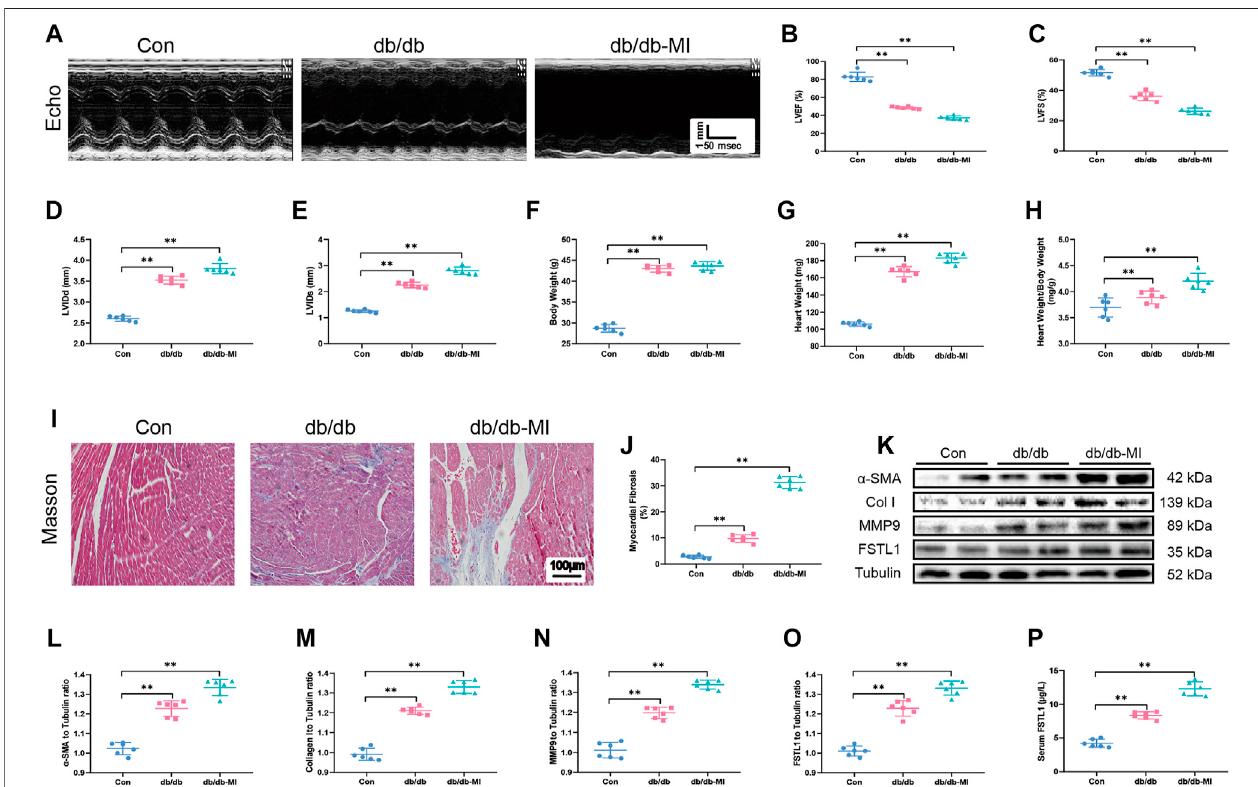
FIGURE 3 | Echocardiographic function, levels of FSTL1 and myocardial fi brosis in diabetic db/db mice following with sham or MI injury. (A) Representative M-mode images of echocardiography challenged with MI injury in diabetic db/db mice; (B) Left ventricular ejection fraction (LVEF); (C) Left ventricular fractional shortening (LVFS); (D) left ventricular internal diameter at end-diastole (LVIDd); (E) Left ventricular internal diameter at end-systole (LVIDs); (F) Body weight; (G) Heart weight; (H) Heart weight to body weight ratio; (I) Cardiac interstitial fi brosis using Masson ’ s Trichrome staining; (J) Pooled data of the interstitial fi brotic area of myocardialtissues; (K) Representative images ofWesternblot in high fat diet-induced T2DM challenged with sham or MI injury; (L) α -SMA level; (M) Collagen Ilevel; (N) MMP9level; (O) FSTL1level;and (P) SerumLDHlevel.Con:normalcontrol; db/db :diabetic db/db mice; db/db -MI, db/db miceunderwentmyocardialinjury.Theresults are presented as Mean ± SEM, n (cid:2) 6 in each group. ** p < 0.01. scale bar (cid:2) 100 μ M.